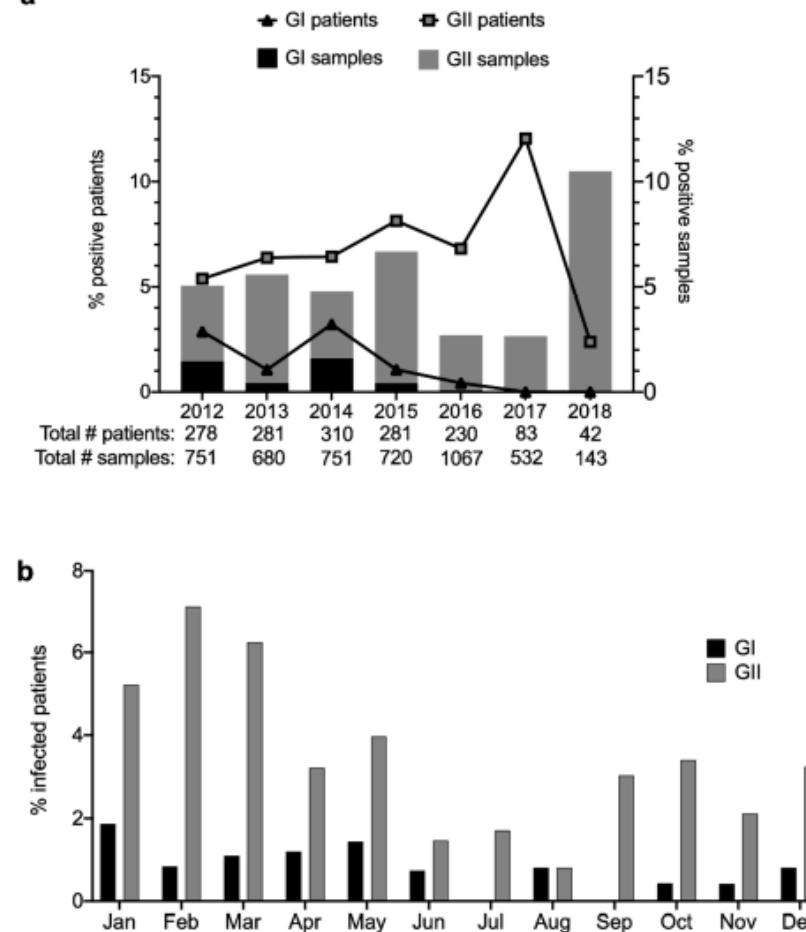
Figure 1. Human norovirus GI and GII infections identified from fecal samples collected over a 6-year period (2012–2018) at a pediatric research hospital. ( a ) Sample and patient positivity are noted for each year, with total numbers of samples and patients analyzed each year listed below ( b ) Seasonal trends observed over time indicate that the burden of norovirus infections was highest from September to May.